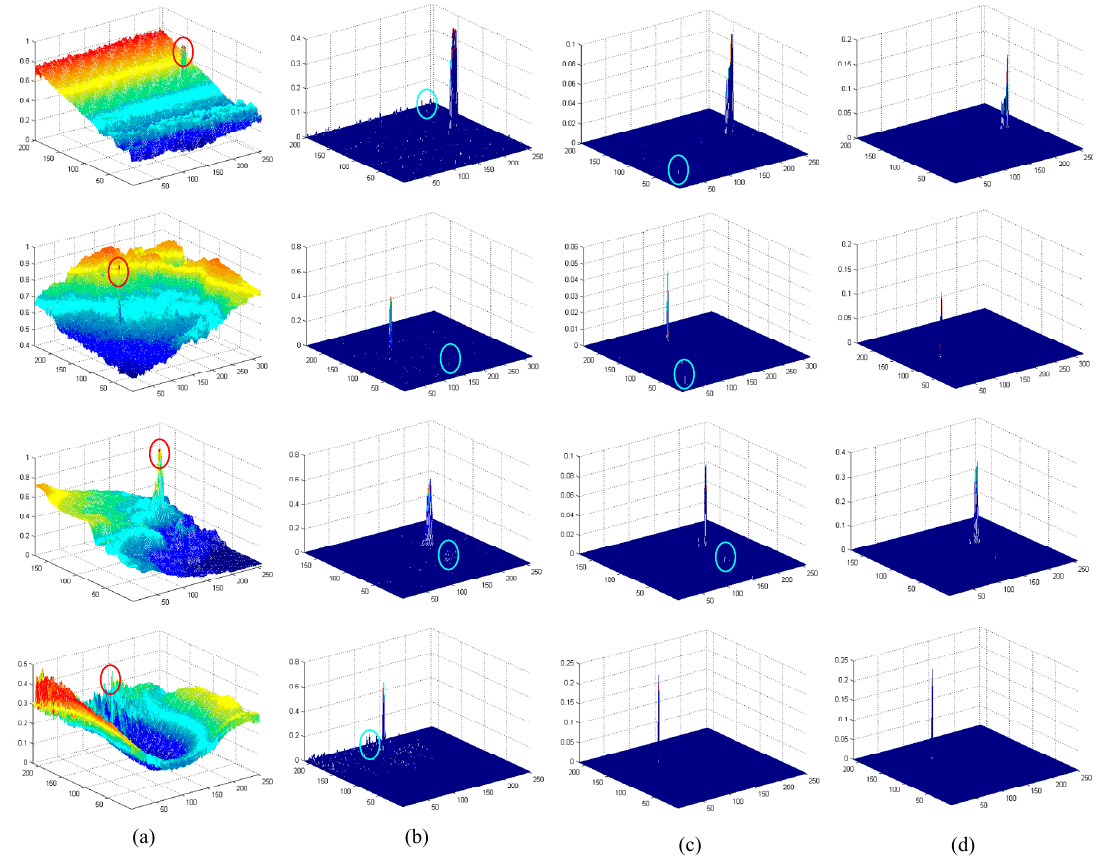
Figure 9. 3D display of figure 8. (a) Original images; (b) IPI processing result; (c) NOSLC processing result; (d) NOLC processing result. Remote Sens. 2019 , 11 , x FOR PEER REVIEW